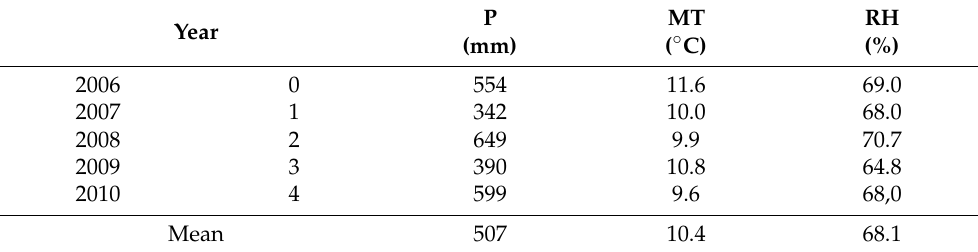
Table 1. Weather conditions measured at the experimental site during the study period.